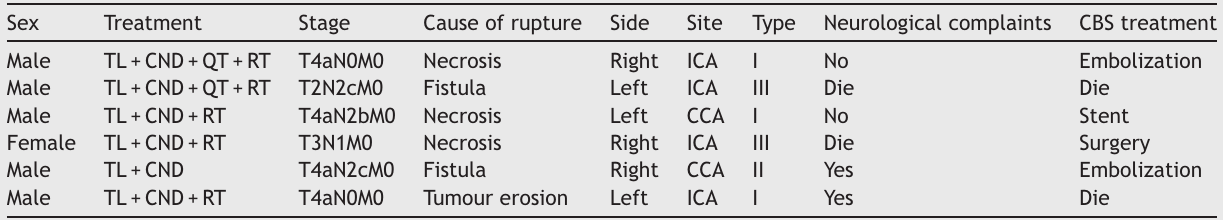
Patient treated by carotid blowout syndrome at our